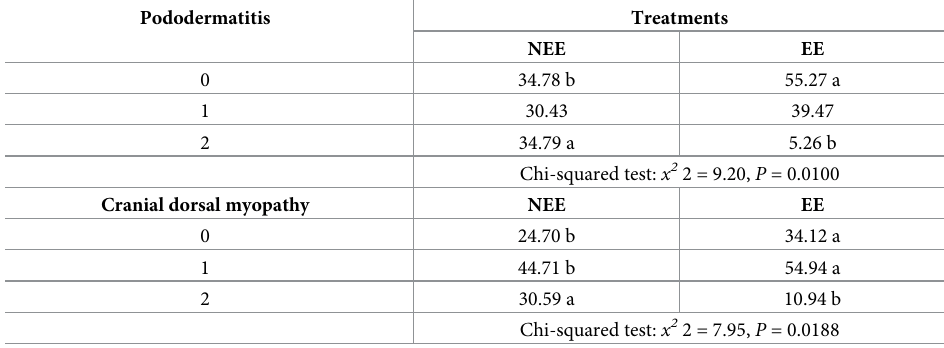
Table 6. Frequencies (scores) of pododermatitis and dorsal cranial myopathy in broiler chickens housed in envi- ronments with and without